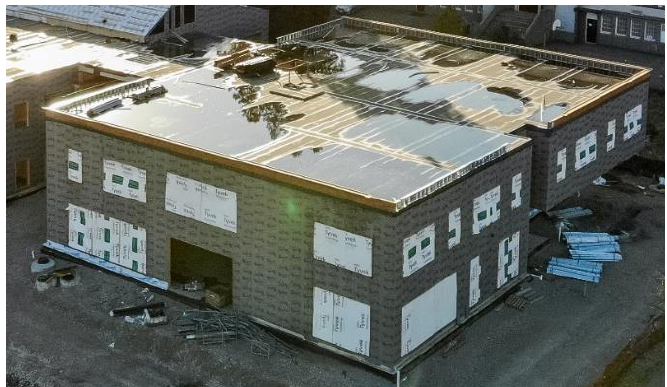
Figure 1. Begbie elementary school (Photo courtesy of Fast + Epp).